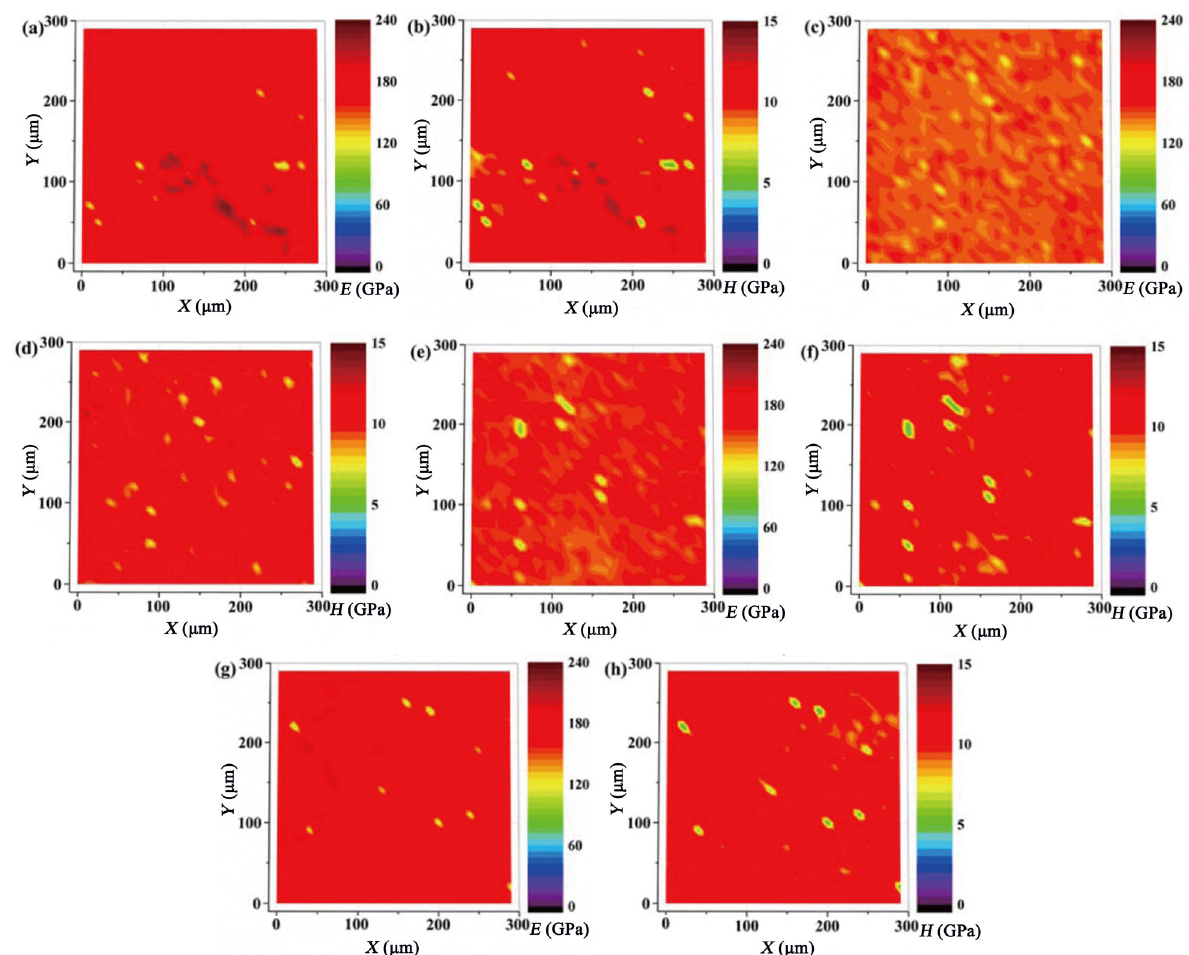
Fig. 6 3D mapping of Young’s modulus ( E ) and hardness ( H ) for HEP RETa 3 O 9 ceramics: (a, b) (La 1/5 Pr 1/5 Dy 1/5 Ho 1/5 Tm 1/5 )Ta 3 O 9 (5HEP-1), (c, d) (Gd 1/5 Dy 1/5 Ho 1/5 Er 1/5 Tm 1/5 )Ta 3 O 9 (5HEP-2), (e, f) (La 1/6 Sm 1/6 Eu 1/6 Dy 1/6 Ho 1/6 Tm 1/6 )Ta 3 O 9 (6HEP-3), and (g, h) (Eu 1/6 Gd 1/6 Dy 1/6 Ho 1/6 Er 1/6 Tm 1/6 )Ta 3 O 9